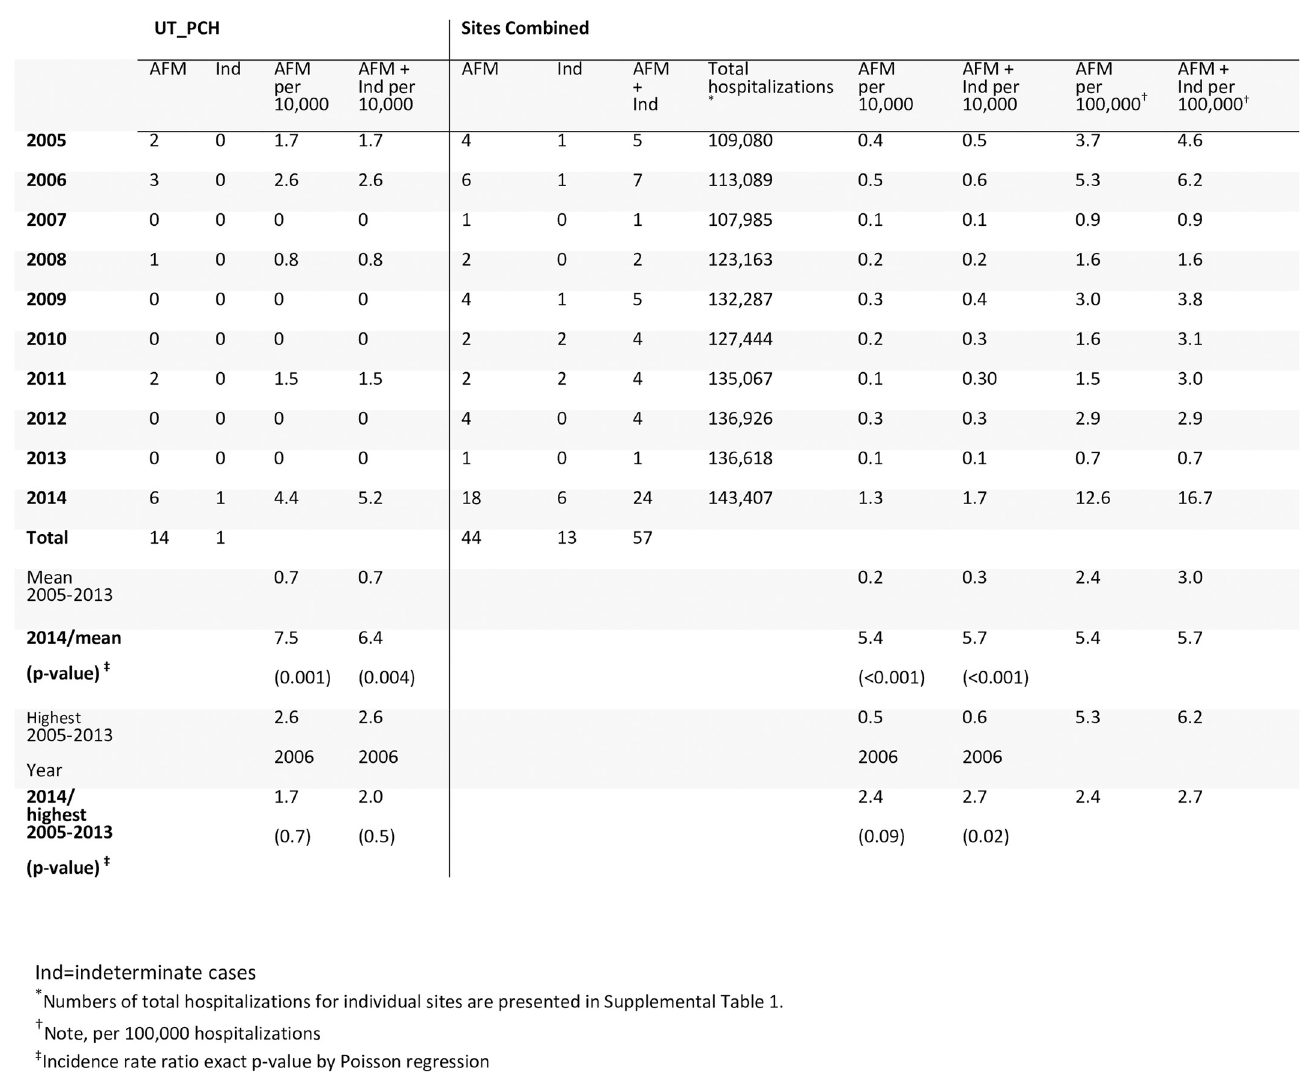
Fig 2. Number of AFM and indeterminate cases by calendar year and site among persons aged � 18 years, and cases per 10,000 pediatric hospitalizations (continued).